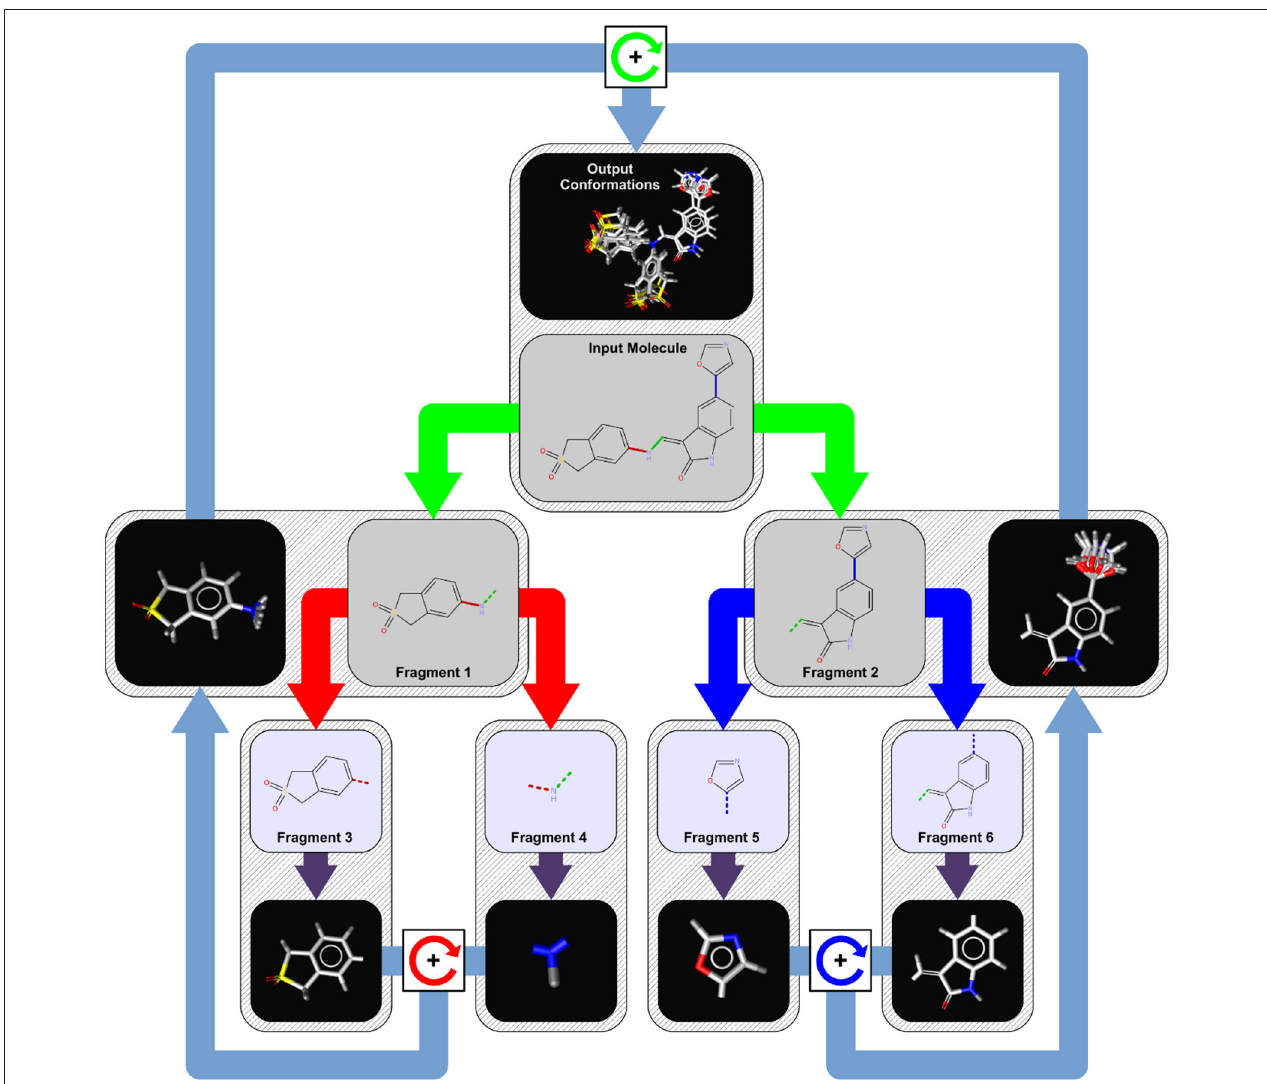
FIGURE 1 | Conformer generation workflow for an example molecule with three rotatable bonds. In the first step, the input molecule is dissected recursively at each of its rotatable bonds (marked in red, green, and blue) into a tree-like structure of fragments (tree nodes) of approximately equal structural complexity. Fragments at the leaf nodes (fragments 3, 4, 5, and 6) represent the smallest rigid conformational units of the input molecule (like ring systems, atoms in chains, etc.) and are assigned initial 3D coordinates by a distance geometry/force field optimization approach (purple arrows). To generate conformer ensembles for flexible fragments (fragment 1 and 2), the coordinates of the two leaf fragments are combined by relative rotations around the connecting rotatable bond (boxes with circular arrows) of the parent fragment using the angles provided by a bond specific (or default) torsion rule. This procedure is repeated until a final set of candidate conformations for the root node (input molecule) has been obtained from which the requested number of output conformations under the given energy window and RMSD constraints are